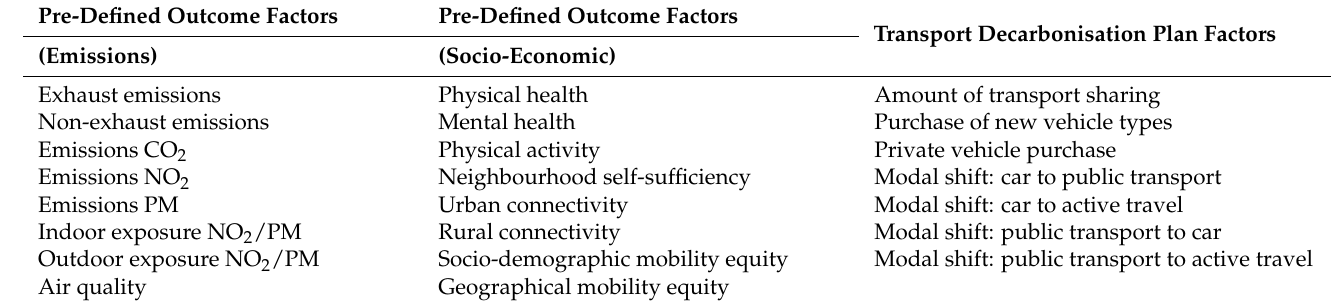
Table 4. Pre-defined factors used to initiate mapping: outcomes and functions of the U.K. surface transportation system and factors relevant to the U.K. Transport Decarbonisation